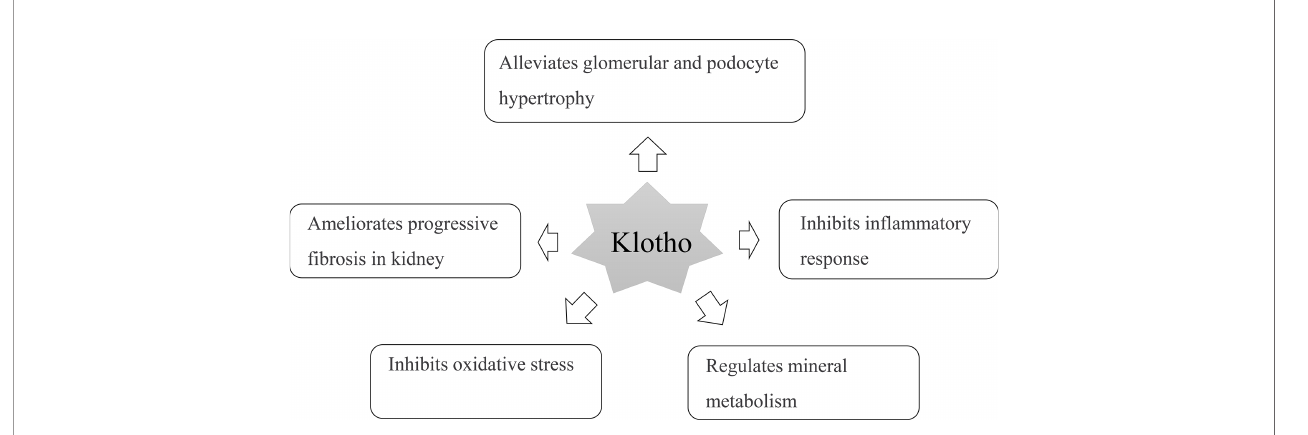
FIGURE 5 | Multifactorial effects of Klotho in the pathology of